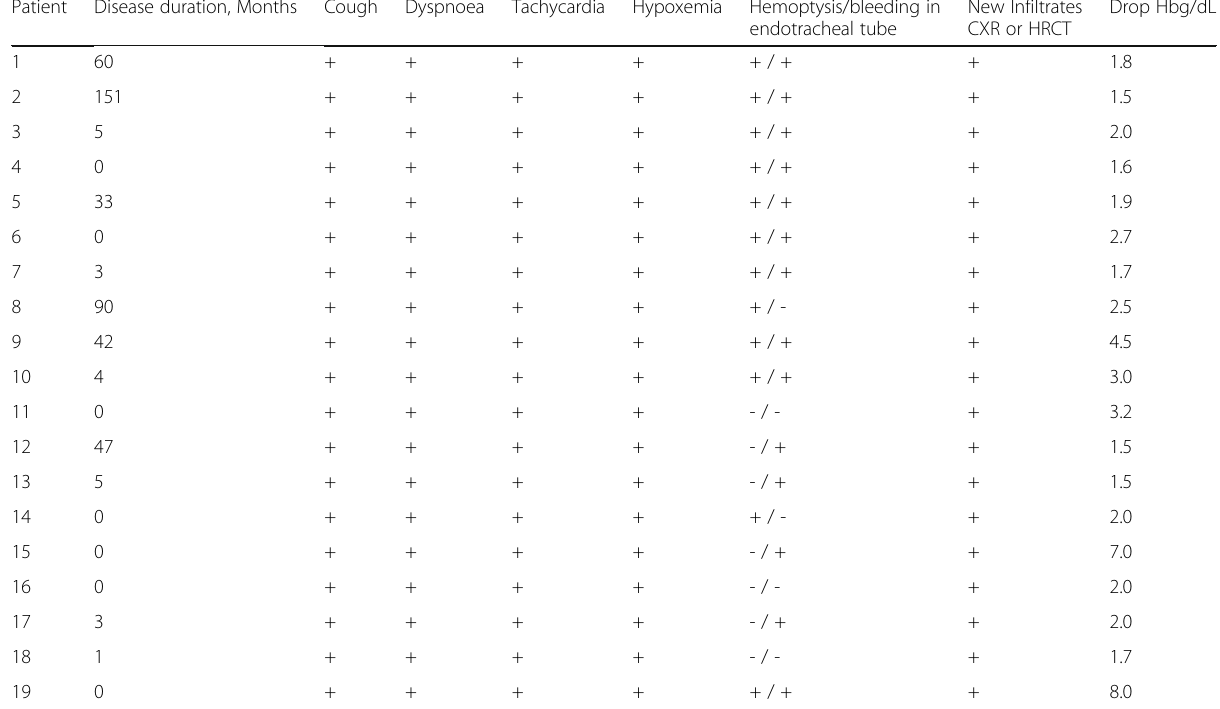
Table 1 Demographic, clinical manifestations and imaging in 19 childhood-onset systemic lupus erythematosus (cSLE) patients with diffuse alveolar hemorrhage Patient Disease duration,